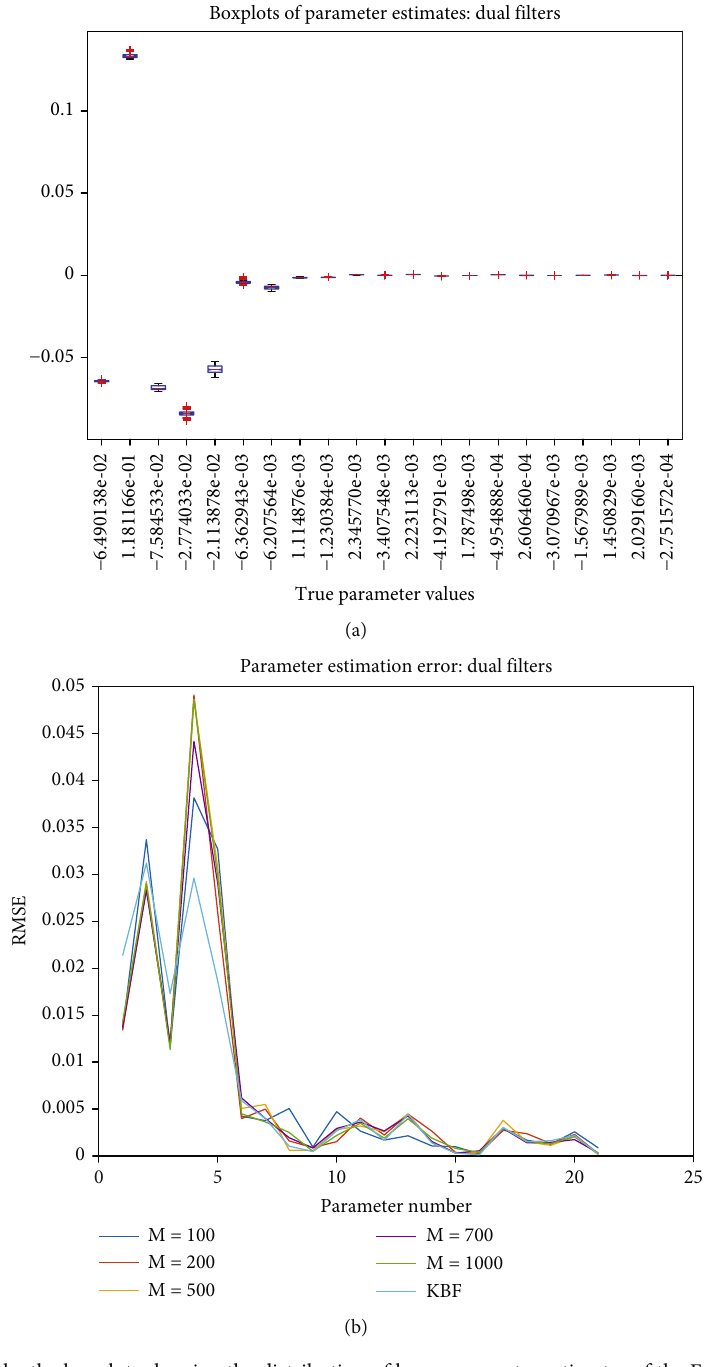
Figure 8: (a, b) are, respectively, the boxplots showing the distribution of hyperparameter estimates of the EnKBF dual fi lter, applied to the advection equation, after a burn-in of 500 iterations and the plots of the root mean square error for the hyperparameter estimates obtained using KBF-EnKBF and EnKBF (with di ff erent ensemble sizes) dual fi